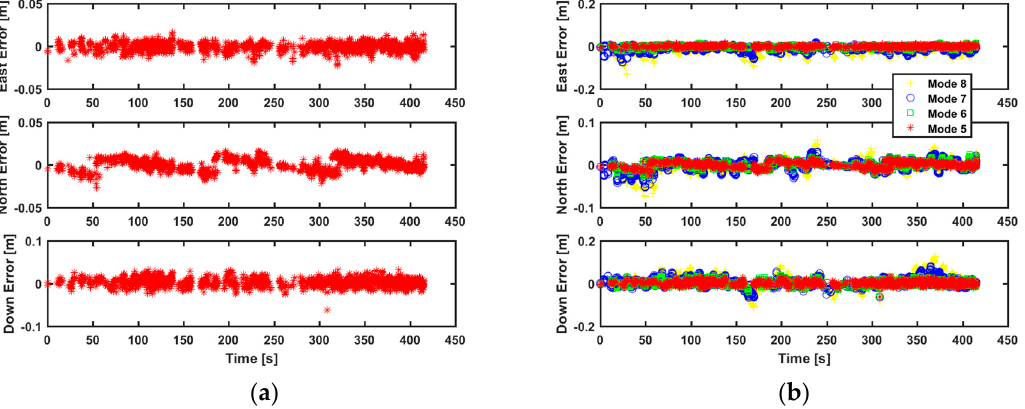
Figure 21. Error scatterplots of relative position in test 2. ( a ) mode 5; ( b ) comparison of modes 5–8.